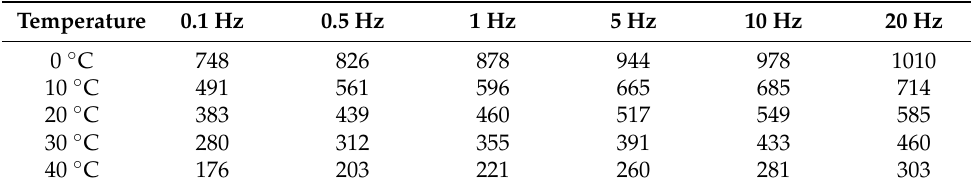
Table 5. The resilience modulus of the separator layer